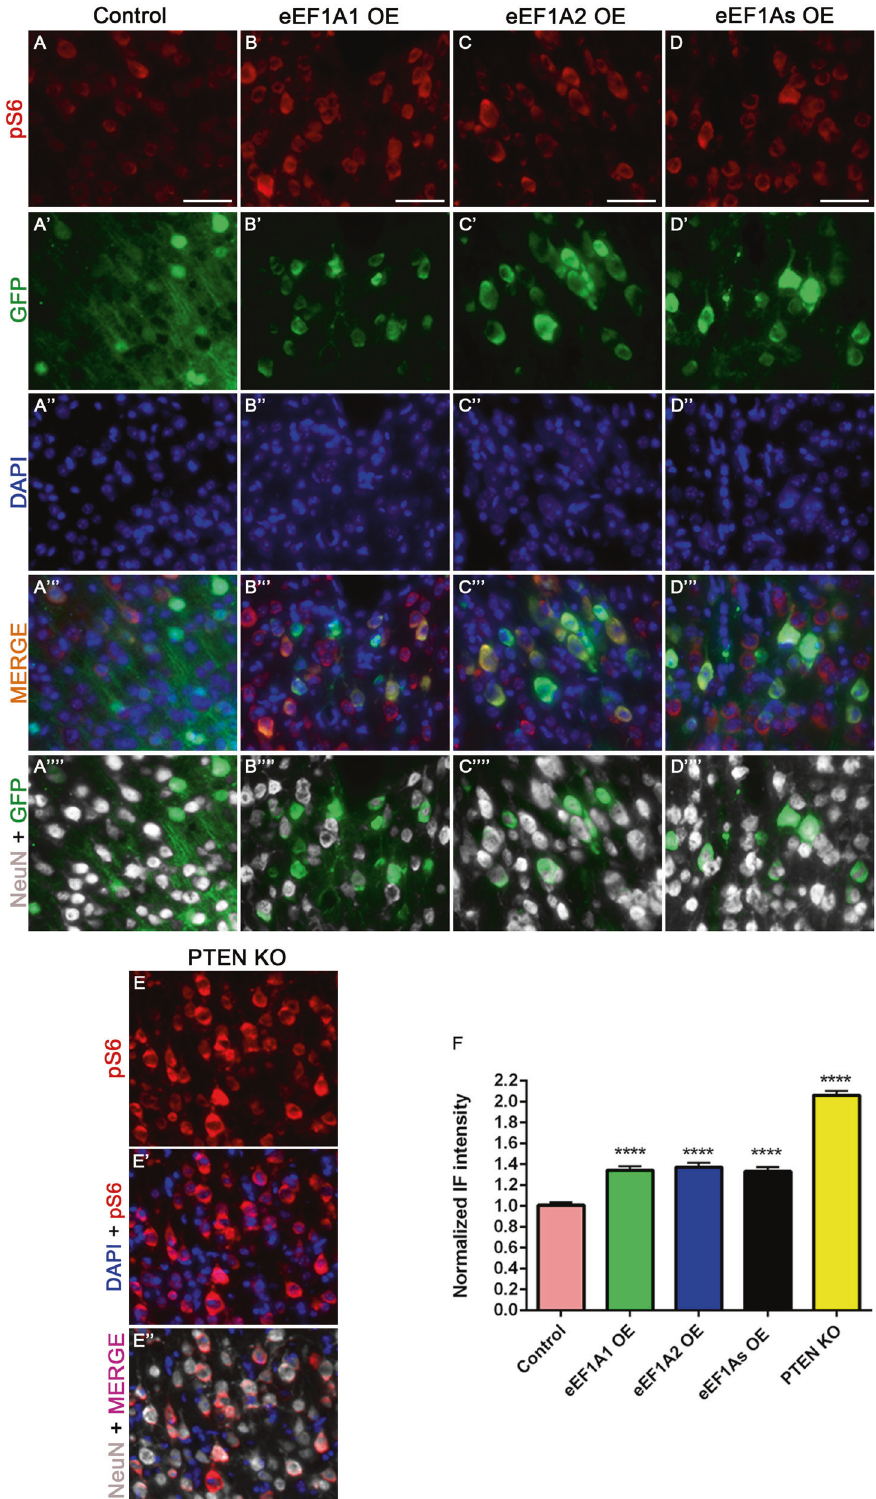
Fig. 3 Overexpression of eEF1A proteins activates mTOR signaling. Representative images of pS6, GFP (viruses), and NeuN staining at the layer V of the right sensorimotor cortex of injured control mice (AAV-GFP injection) ( A – A ”” ); injured eEF1A1-overexpressing (OE) mice ( B – B ”” ); injured eEF1A2-OE mice ( C – C ”” ); injured eEF1As-OE mice ( D – D ”” ); and injured PTEN cKO mice serving as a positive control ( E – E ” ). F Quanti fi cation of pS6 immunoreactivity. Scale bars: 50 μ m. Control, 12 mice; eEF1A1, 10 mice; eEF1A2, 10 mice; eEF1As, 8 mice; PTEN cKO, 4 mice; 20 cells quanti fi ed per mouse. Stats: One-way ANOVA with Kruskal – Wallis Test. Bars show mean ± SEM. **** p < 0.0001.